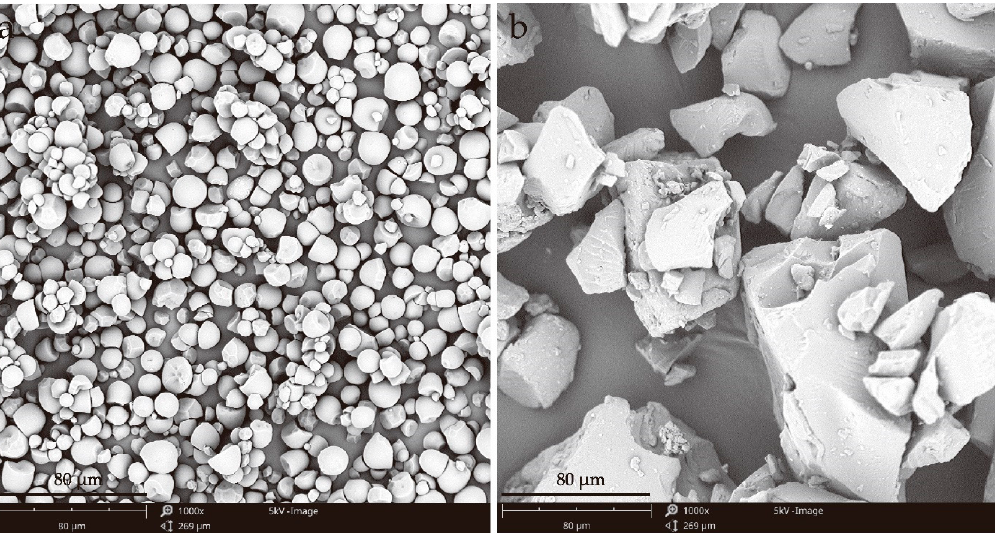
Figure 1. Scanning electron micrographs of ( a ) pristine starch (1000×) and ( b ) plasticized starch (1000×).